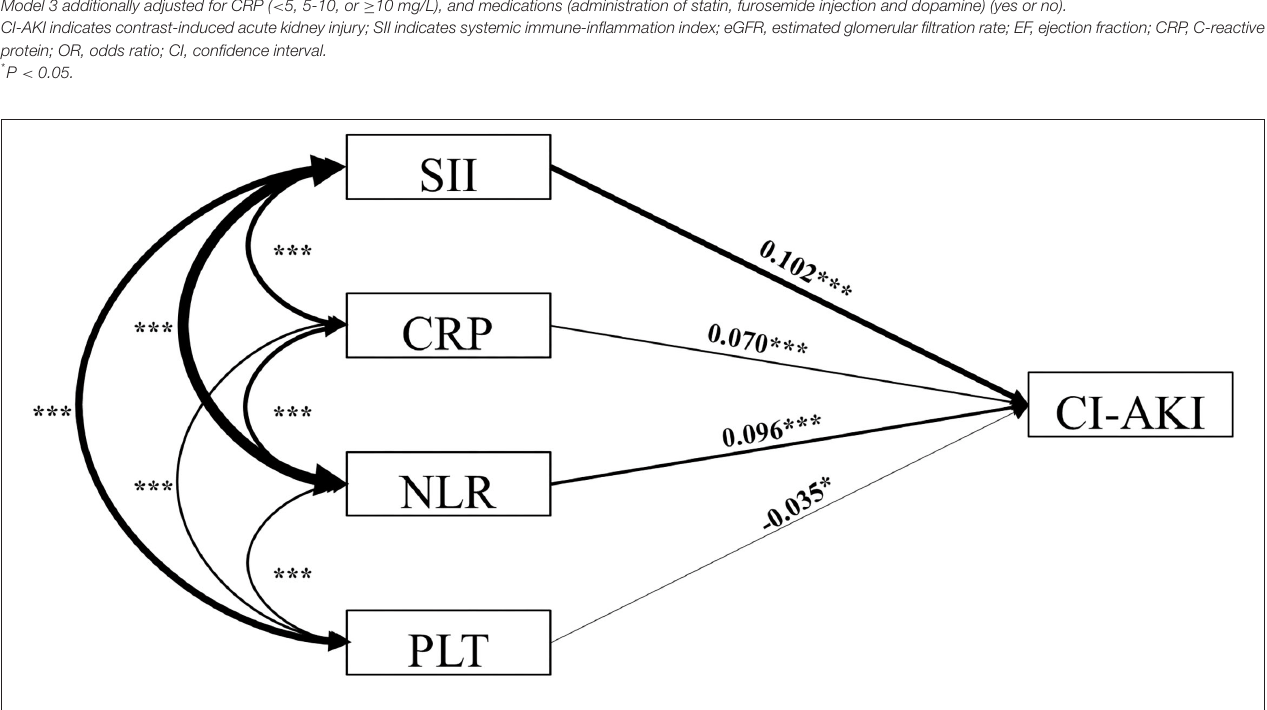
FIGURE 3 | Structural equation model diagram. The structural equation model diagram depicted the relationship between variables by the solid arrows (valid paths). Standardized regression coefficients are presented beside solid arrows. Asterisks indicate the significance levels: ( * ) P < 0.05; ( ** ) P < 0.01; ( *** ) P < 0.001. The direction (causality) and the degree of correlation of the mutual impacts of the variables are reflected by the direction and thickness of the arrows. SII indicates systemic immune-inflammation index; CI-AKI, contrast-induced acute kidney injury; CRP, C-reaction protein; NLR, neutrophil to lymphocyte ratio; PLT,